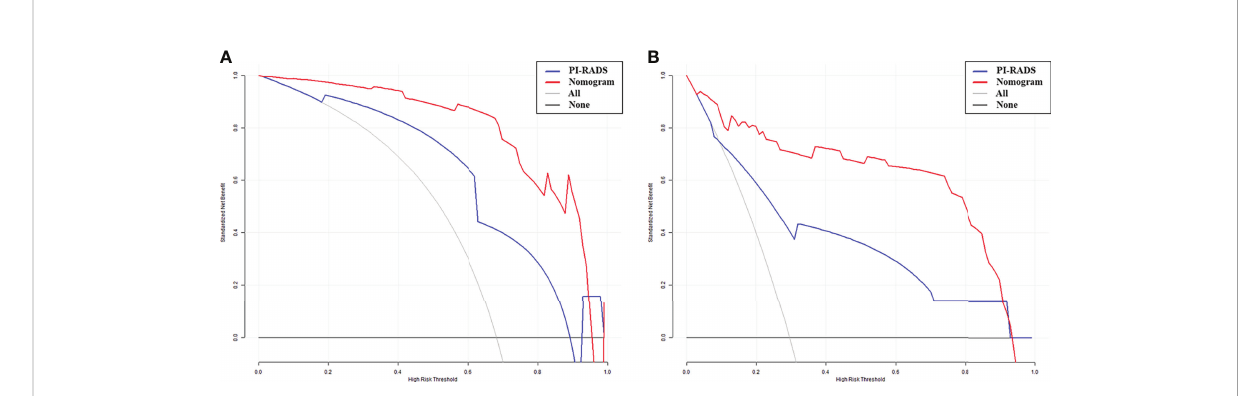
FIGURE 5 Decision curve analysis (DCA) of the nomogram and PI-RADS models. X-axis, risk threshold of CS-PCa; Y-axis, net bene fi t. Black line, all cases assumed to be clinically insigni fi cant; gray line, all cases considered clinically signi fi cant. The nomogram model had enhanced net bene fi t compared with the PI-RADS at large probability thresholds (0.0-0.9). (A) In validation set 1. (B) In validation set